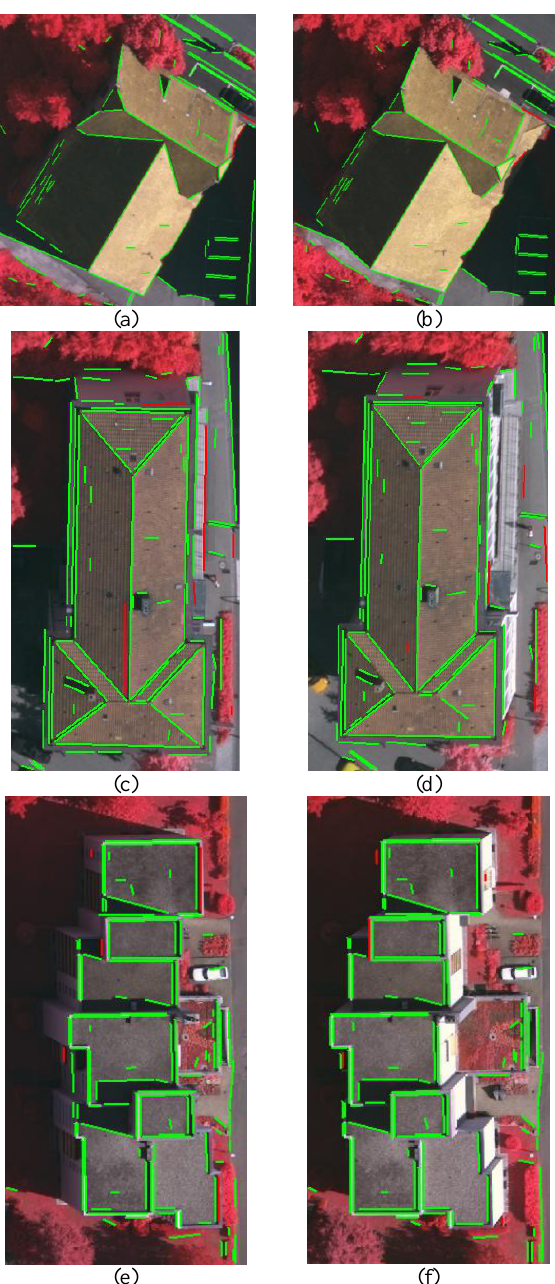
Fig. 7. Test patches. Left (a-c-e) and right (b-d-f) stereo images. Correct and false matches are shown in green and red colors,